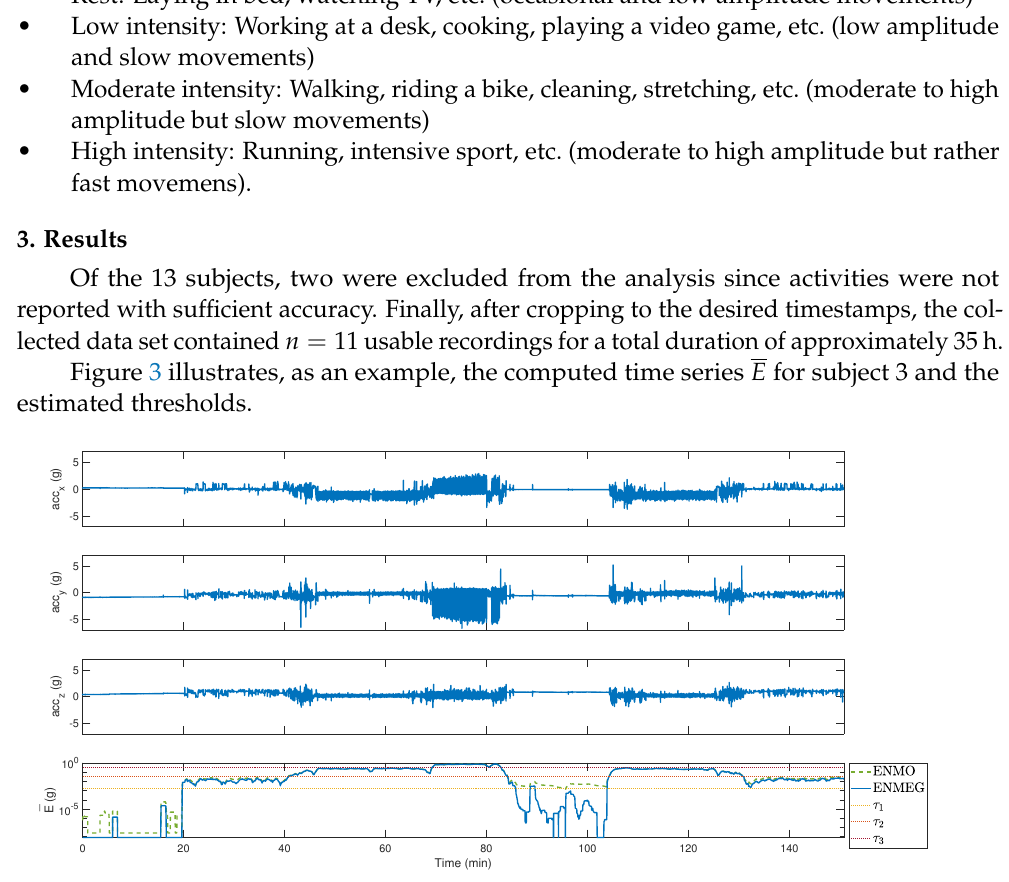
Figure 3. Raw accelerometers data from subject 3 along axis x, y and z and the corresponding averaged ENMEG signal E plotted on a logarithmic scale for better reading in blue, the regular ENMO (without gravity estimation) is displayed as reference in dashed green, the doted lines are the activity thresholds. The involved activities were, in order: resting, desk working, walking, running, resting, walking and desk